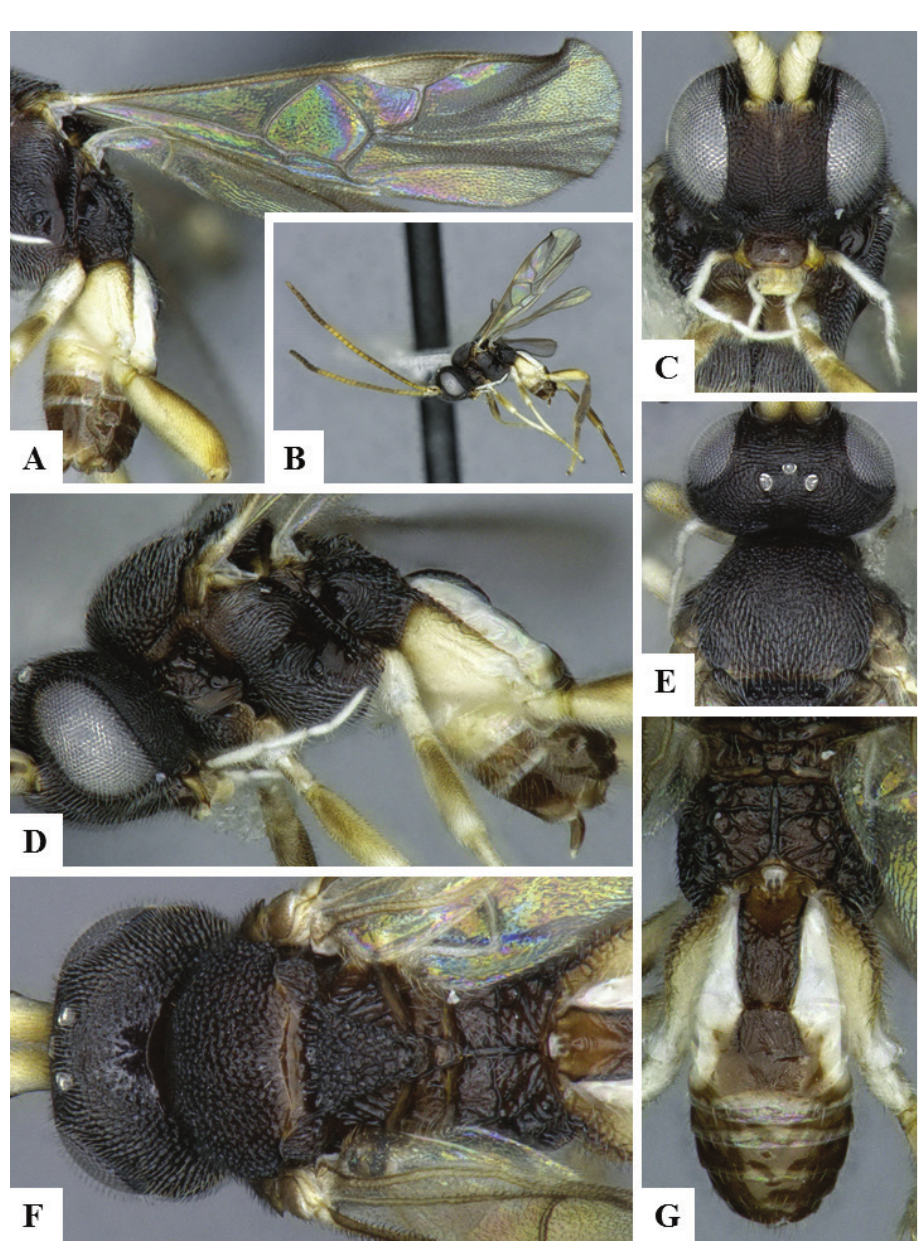
Figure 13. Gilbertnixonius biem female holotype. A Fore wing B Habitus C Head frontal D Mesosoma and metasoma, lateral E Head dorsal F Mesosoma dorsal G Propodeum and metasoma, dorsal. spur L: 0.11; Outer spur L: 0.09; First segment of Metatarsus L: 0.32; Ovipositor sheaths L: 0.14; Body L: 2.13; Fore wing L: 2.14. Male.